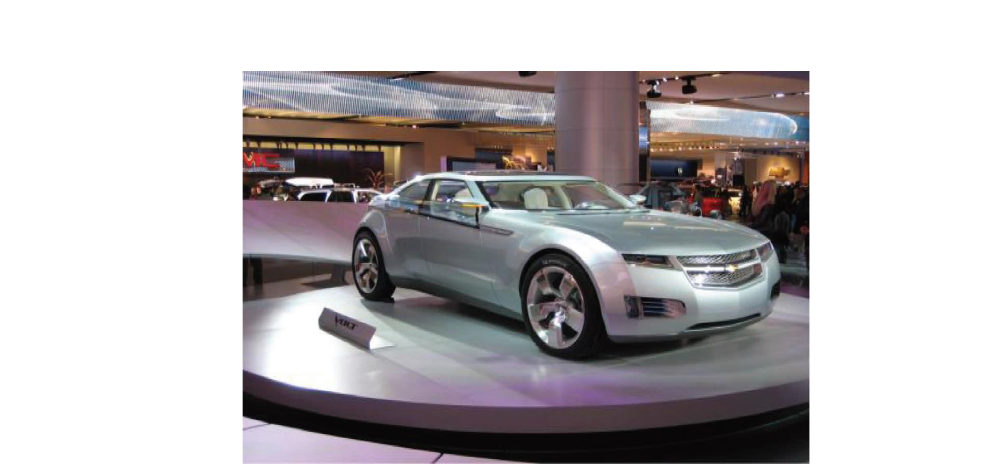
Figure 15: Te concept of the Chevrolet volt-based model